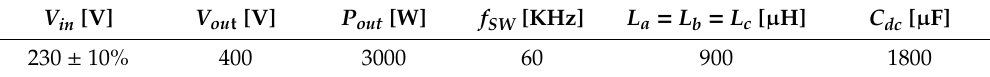
Table 2. Main PFC electrical parameters of the experimental prototype.